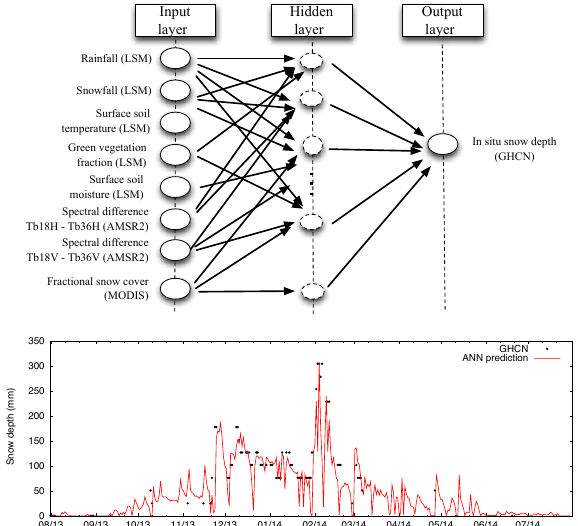
Figure 8. Example of the ML layer utilization in LDT. The top panel shows the schematic of the ANN which ingests a suite of LSM-based and remote-sensing-based inputs for developing pre- dictions of snow depth. The bottom panel shows the performance of the trained network against in situ observations from the GHCN